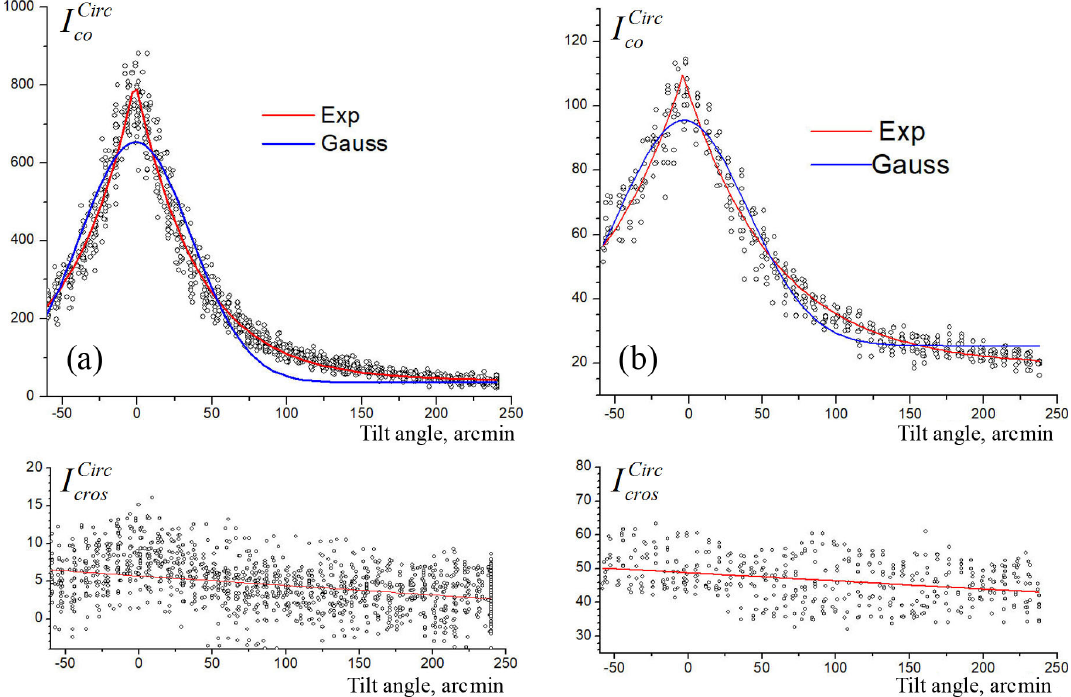
Figure 11. Typical angular dependences of the intensity of polarization components on 2 June 2018. Top frames: co-polarized components I circ co . Bottom frames: I circ cros . (a) Averaging over the layer from 11470 to 11600m at 12:00LT. (b) The layer 10980–11270m at 10:00LT. The record (a) shows low depolarization ratio and narrow ( w = 42arcmin) distribution. The record (b) has a wider distribution ( w = 82arcmin) and large depolarization.